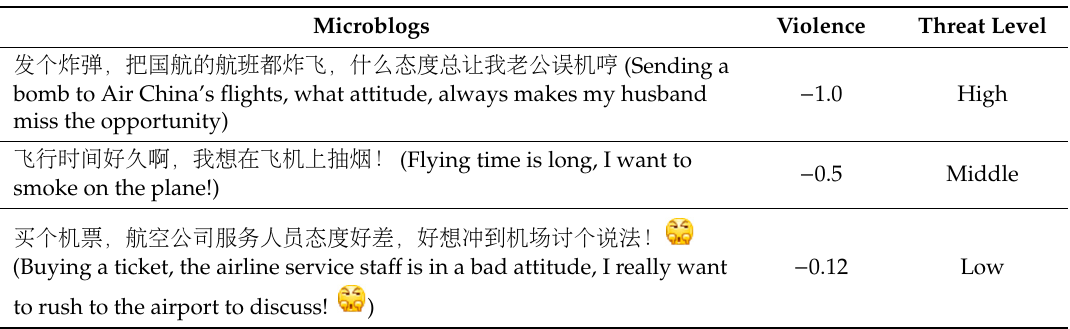
Table 5. Calculated threat